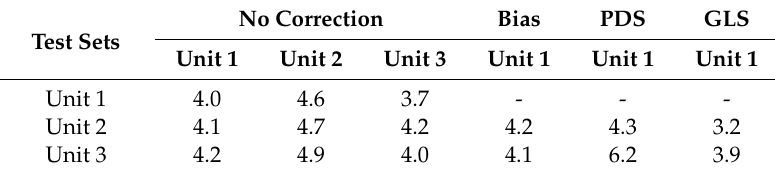
Table 5. The normalized root mean square error of prediction (NRMSEP, %) for